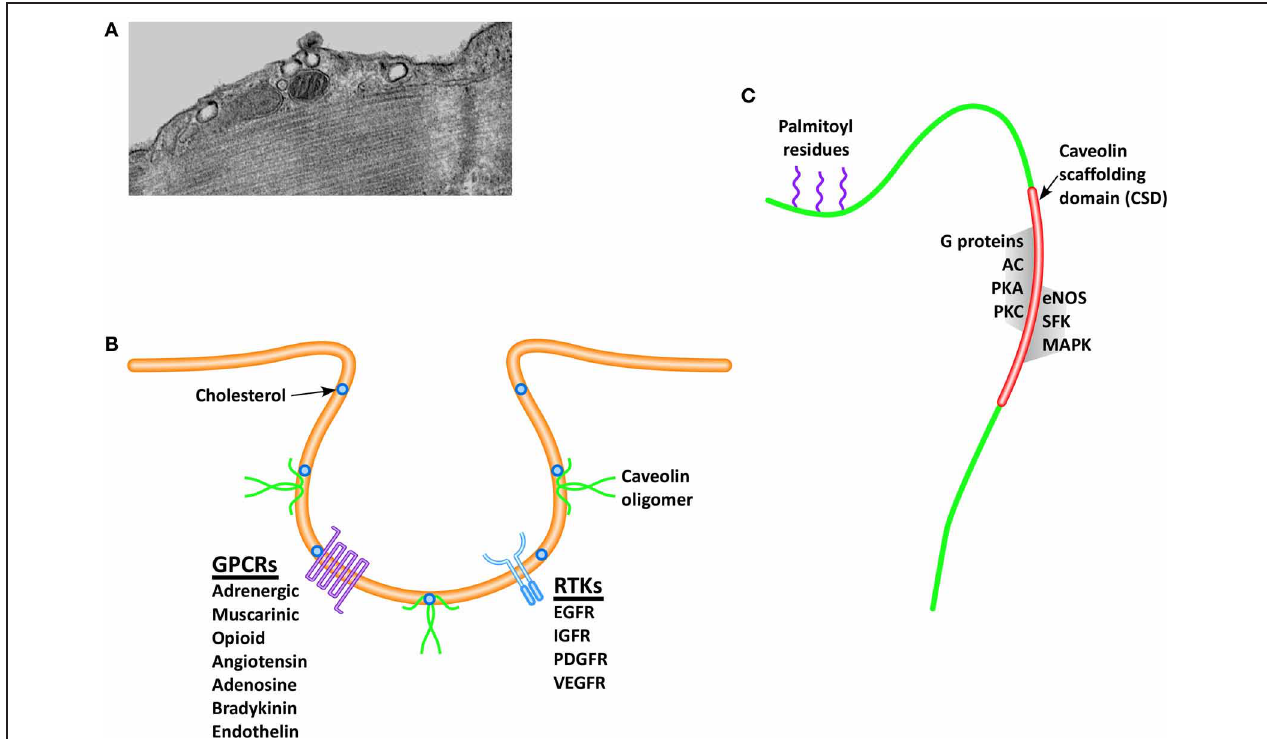
stabilize the protein within the cell membrane, and a scaffolding domain, which is the binding site for many pro-survival and pro-growth molecules. (Definitions: EGFR, epidermal growth factor receptor; IGFR, insulin growth factor receptor; PDGFR, platelet derived growth factor receptor; VEGFR, vascular endothelial growth factor receptor; AC, adenylyl cyclase; PKA, protein kinase A; PKC, protein kinase C; eNOS, endothelial nitric oxide synthase; SFK, Src family kinases; MAPK, mitogen activated protein